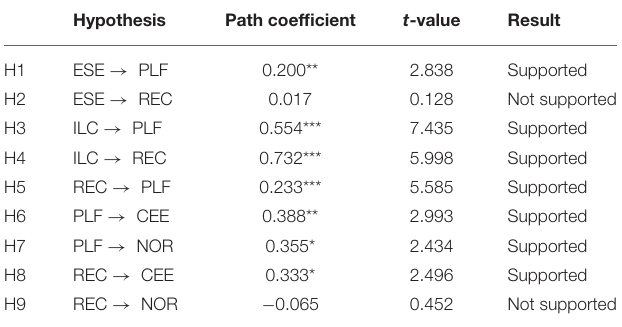
TABLE 6 | Summary of the inner model